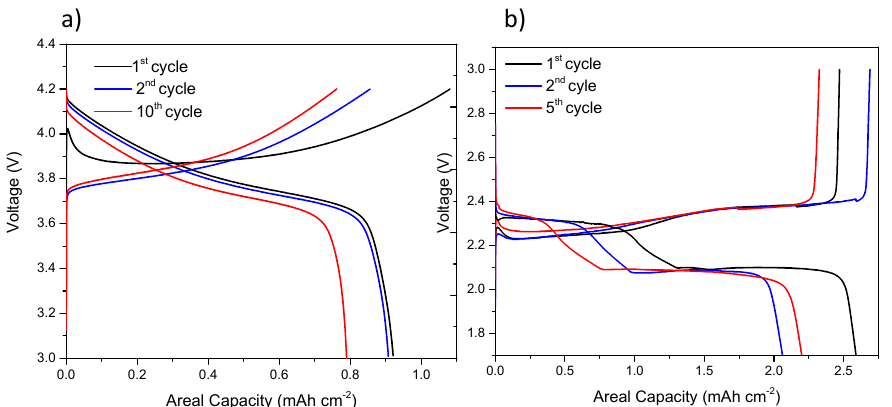
Figure 6. Electrochemical cycling data of ( a ) Li-ion half-cell with NMC positive electrode and ( b ) Li-S cell with elemental sulfur electrode.